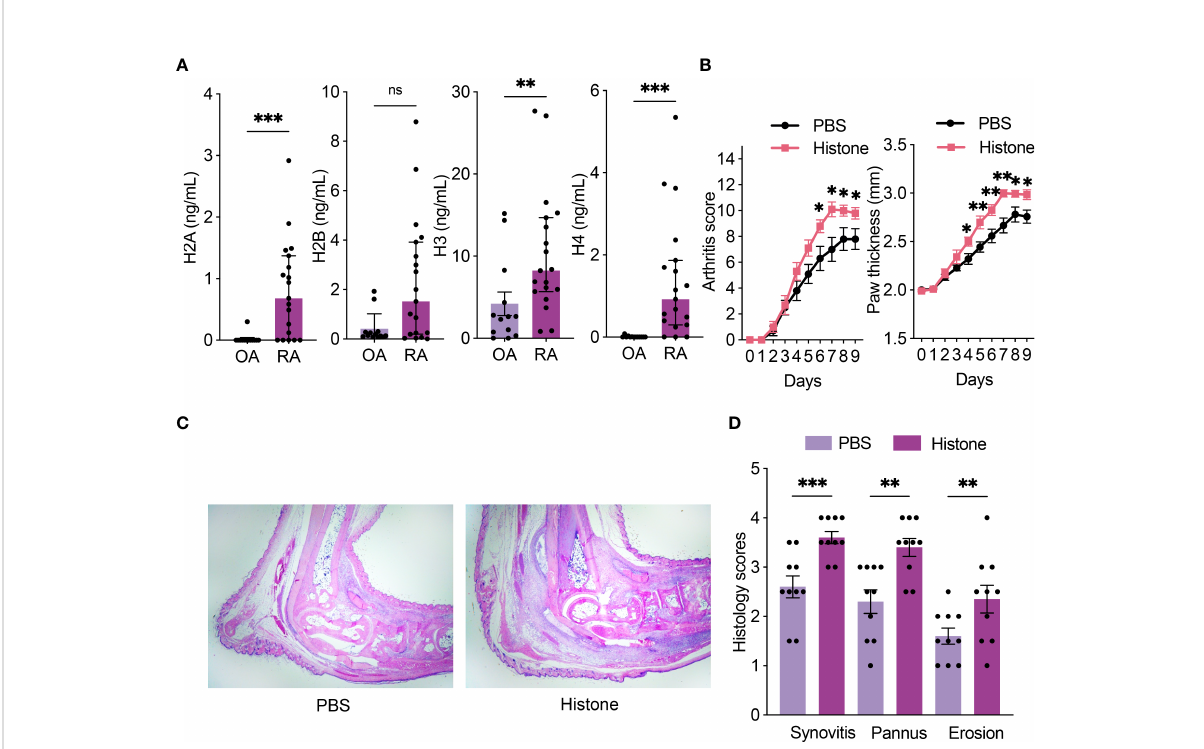
FIGURE 1 Histones are increased in RA synovial fl uid and aggravate arthritis in STA mice. (A) Levels of histones (H2A, H2B, H3, and H4) in synovial fl uid from osteoarthritis (OA; n = 13) and rheumatoid arthritis (RA; n = 19) patients. (B) Serum-transfer arthritis (STA) severity and paw thickness in mice (n = 10 per group) with intraperitoneal histone or phosphate-buffered saline (PBS) injection. K/BxN serum was given on days 0 and 2, and 200 m g of histone or PBS was given on days 1 and 3. (C) Representative images of hematoxylin and eosin (H&E) stained sections of ankle joints (×20 magni fi cation). (D) Histologic scores of synovitis, pannus formation, and erosions of ankle joints. Data are shown as the median ± interquartile range (A) or the mean ± standard error of the mean (B and D). The P -values were calculated by Mann – Whitney tests (A) or unpaired t-tests (B, D) . * P < 0.05, ** P < 0.01, and *** P < 0.001. ns, not signi fi